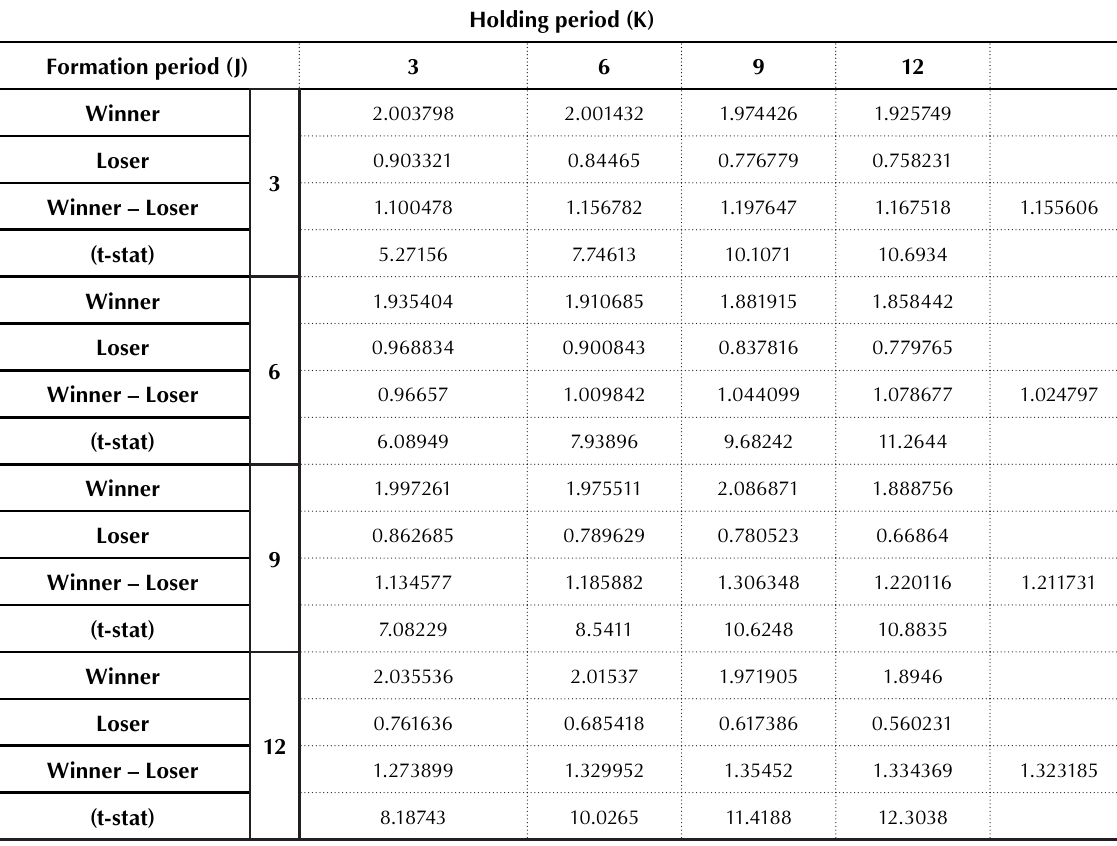
Table 4. Returns of trading vol (low trading volume) momentum strategies Holding period